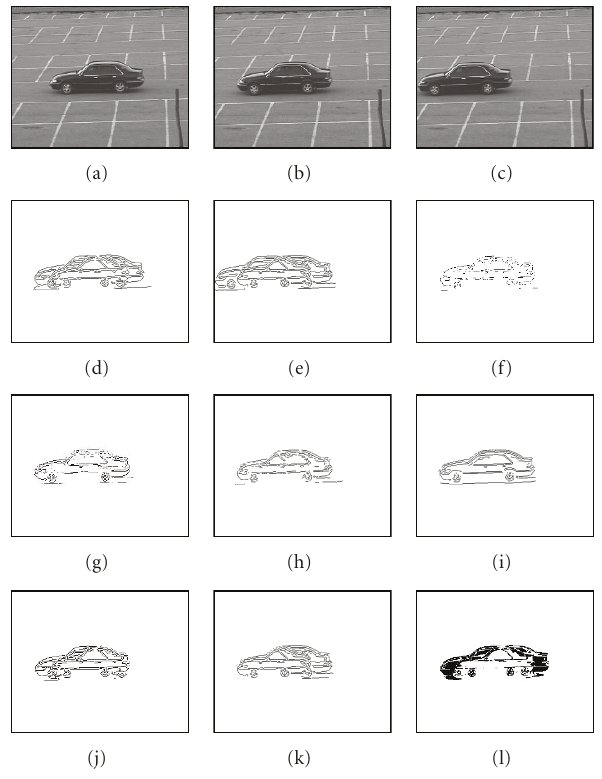
Figure 1: Illustration of problems in existing methods. (a) I n − 1 ; (b) I n ; (c) I n +1 ; (d) left di ff erence image edge map; (e) right di ff erence image edge map; (f) scattered moving edges obtained from exact matching of left and right di ff erence image edge maps; (g) moving edges obtained using more than three consecutive frames; (h) moving edges obtained allowing some distance threshold during matching; (i) edges expected to be extracted for moving object in I n ; (j) edges of left di ff erence image edge map within the region of moving object in I n ; (k) edges of left and right di ff erence image edge maps within the region of moving object in I n ; (l) missing of moving object region in three-frame based method due to region